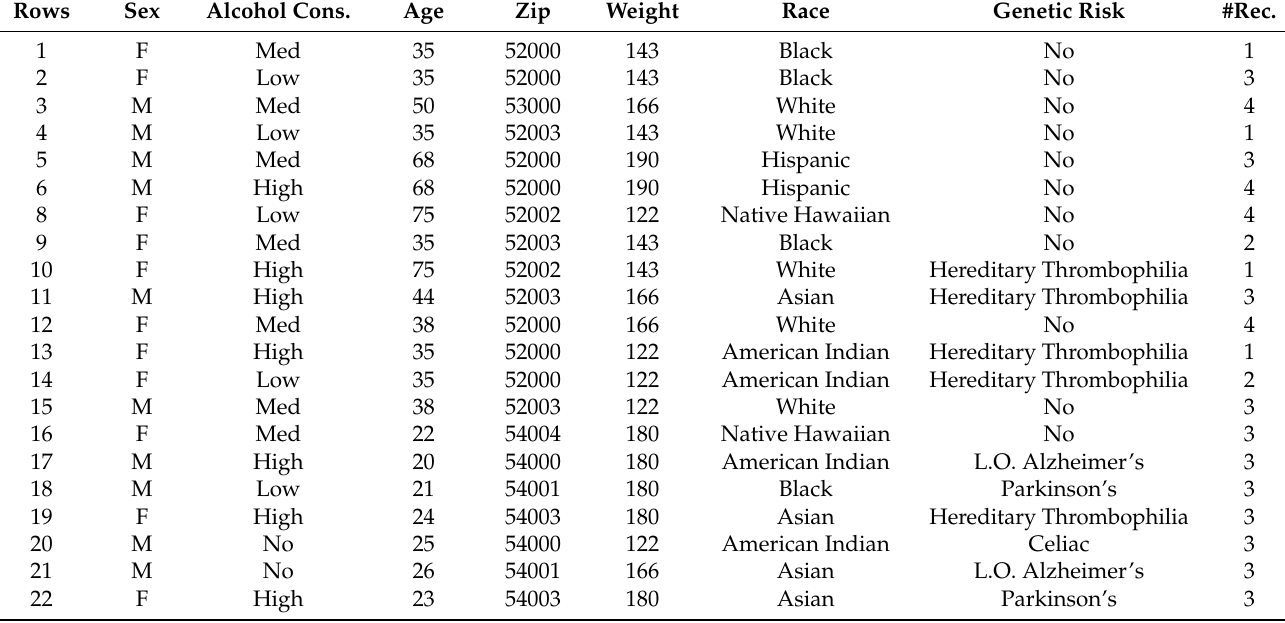
Table 1. Users’ Weight Loss Profiles.